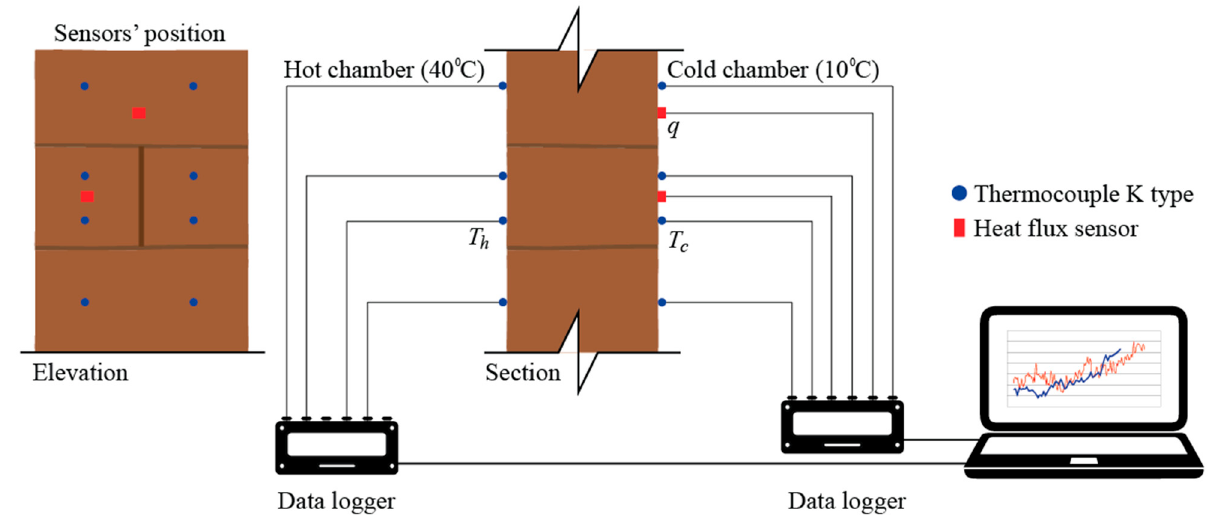
Figure 7. Configuration of the sample wall and position of the sensors. Table 4. Equipment used for thermal transmittance test setup and